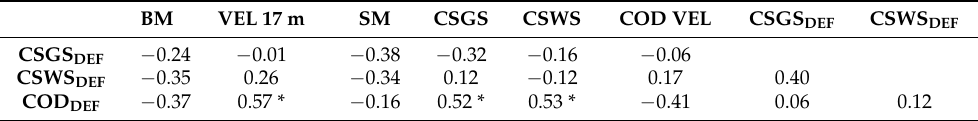
Table 3. Correlation coefficients between jump performances, linear sprint, curve sprint, and change of direction velocities, and curve sprint and change of direction deficits. VEL 17 m CSGS CSWS COD VEL CSGS DEF CSWS DEF COD DEF SJ 0.55 * 0.64 * 0.59 * 0.32 − 0.40 − 0.22 − 0.30 CMJ 0.45 * 0.56 * 0.53 * 0.21 − 0.43 THJW 0.55 * 0.55 * 0.53 * 0.42 − 0.05 0.02